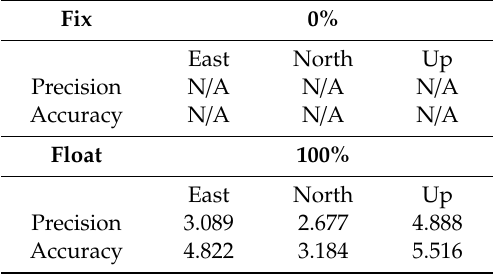
Table 11. Real-time positioning results using Huawei receiver and a session length equal to 5 min. Values in meters.